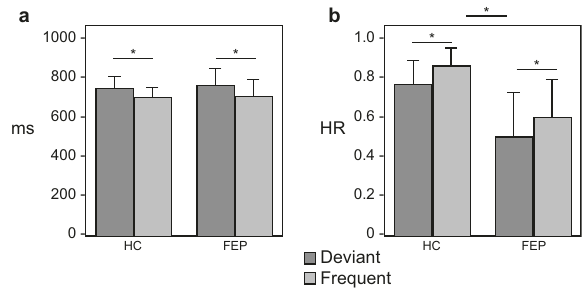
Fig. 1 Behavioral performance in the experimental paradigm. a Reaction times revealed delayed responses for deviant vs. frequent tones, with no differences between groups. b Hit rates showed reduced performance for deviant compared with frequent tones in both groups. The FEP group also showed reduced general performance along the task. The error bars represent the standard deviation. * p <